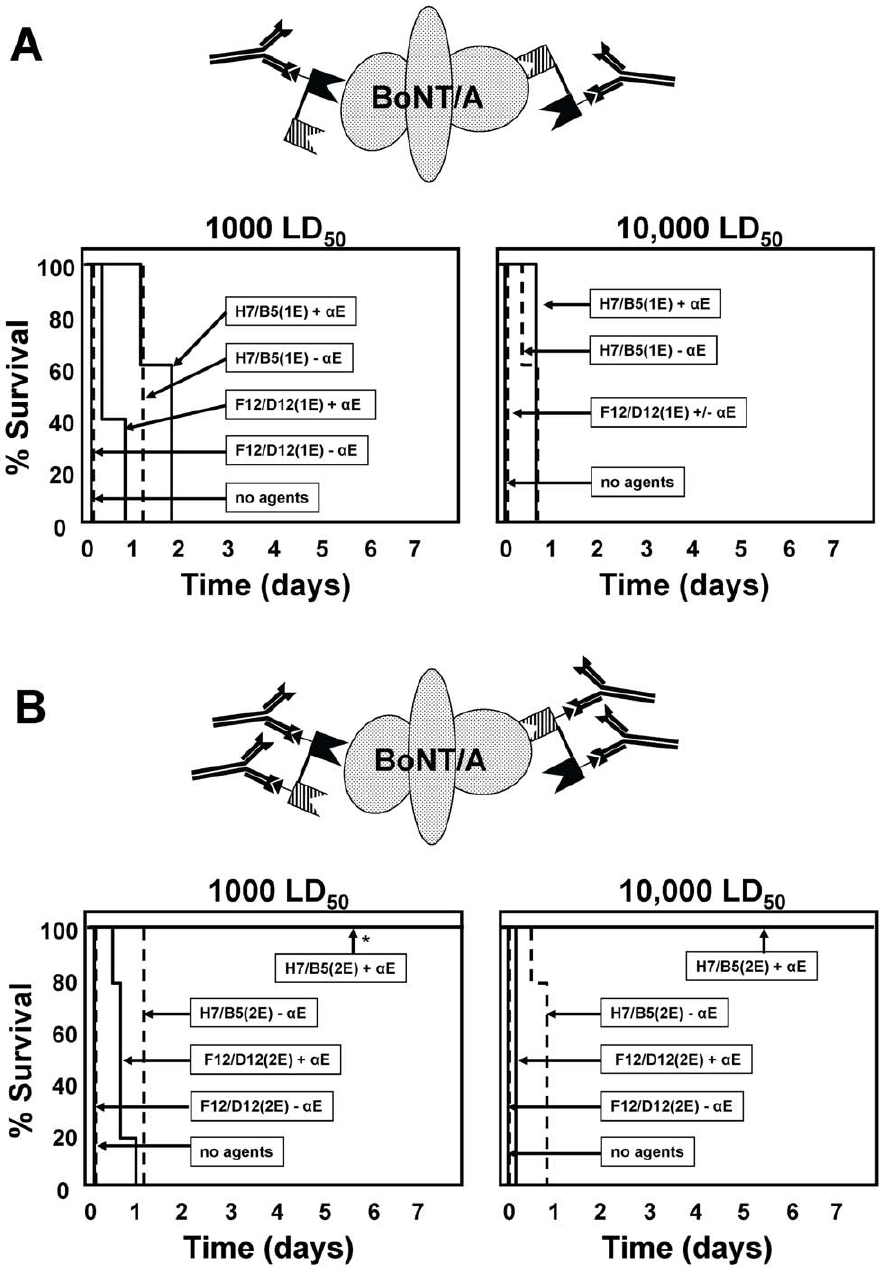
Figure 4. BoNT/A intoxication is prevented in mice by co-administration of a single anti-BoNT/A VHH heterodimer and a clearing Ab. Symptoms of BoNT/A intoxication and lethality were monitored following administration of single- or double-tagged heterodimers of neutralizing or non-neutralizing anti-BoNT/A VHHs + / 2 clearing Ab, or no agents. Time to death is plotted as % survival as a function of time. ( A ) Heterodimers with a single E-tag consisting of two non-neutralizing VHHs (F12/D12(1E)) or two neutralizing VHHs (H7/B5(1E)) were co-administered to groups of five mice with or without anti-E-tag clearing Ab ( a E) and the indicated dose of BoNT/A. ( B ) Heterodimers with two copies of the E-tag and consisting of two non-neutralizing VHHs (F12/D12(1E)) or two neutralizing VHHs (H7/B5(1E)) were co-administered to groups of five mice with or without anti-E-tag clearing Ab ( a E) and the indicated dose of BoNT/A. An asterisk indicates that mice did not display any symptoms of intoxication.